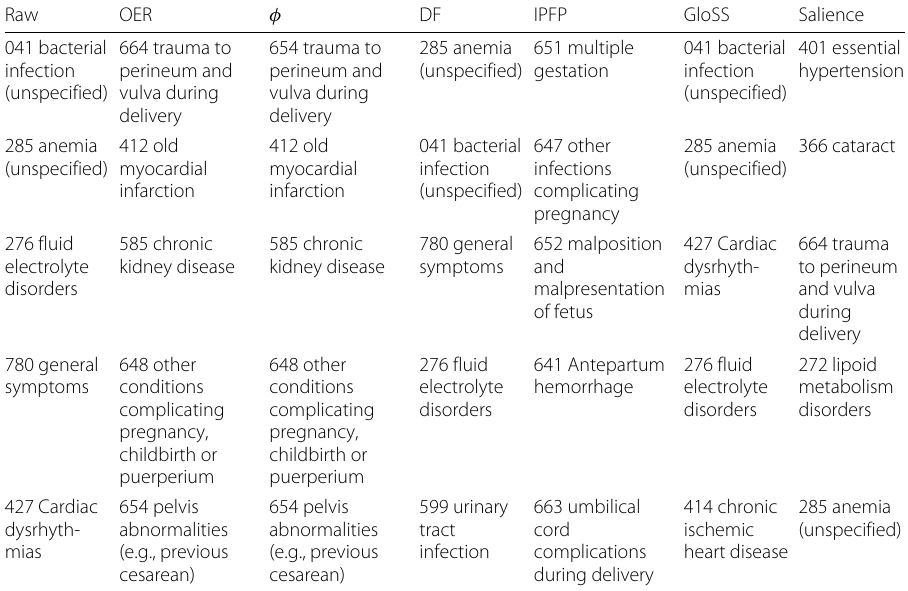
Table 6 Top 5 diseases with highest eigenvector centrality in different networks Raw OER φ DF